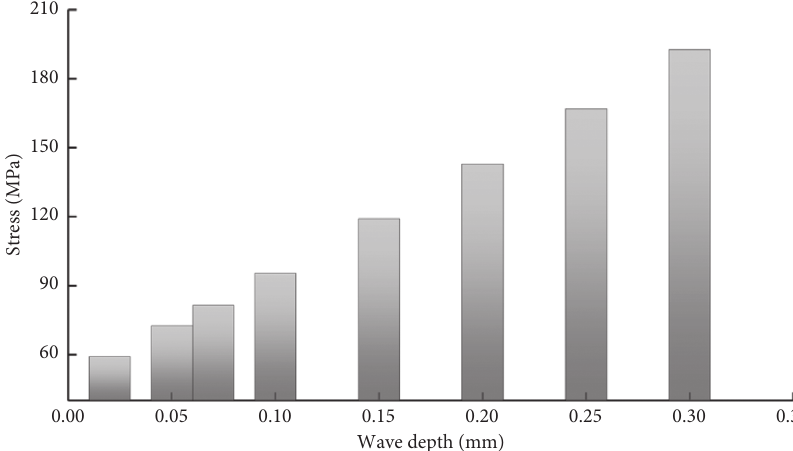
Figure 12: Influence of the wave depth on the axle stress.